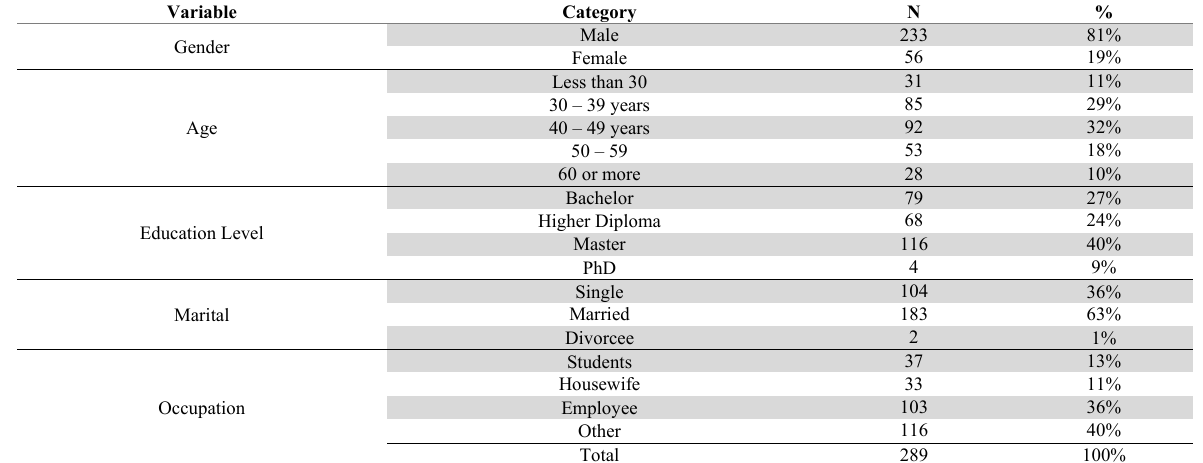
Personal characteristics of the